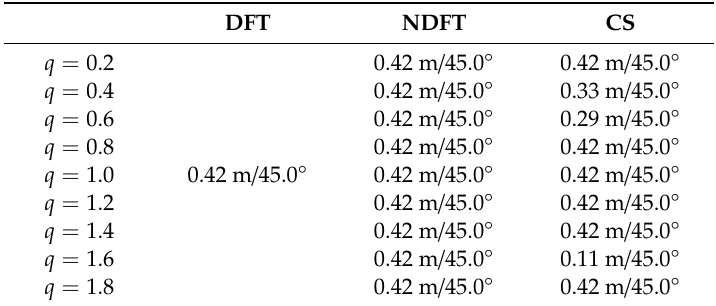
Table 2. Actual imaging height error and phase. CS: compressive sensing; DFT: discrete Fourier transform; NDFT: non-uniform discrete Fourier transform. DFT NDFT CS q =